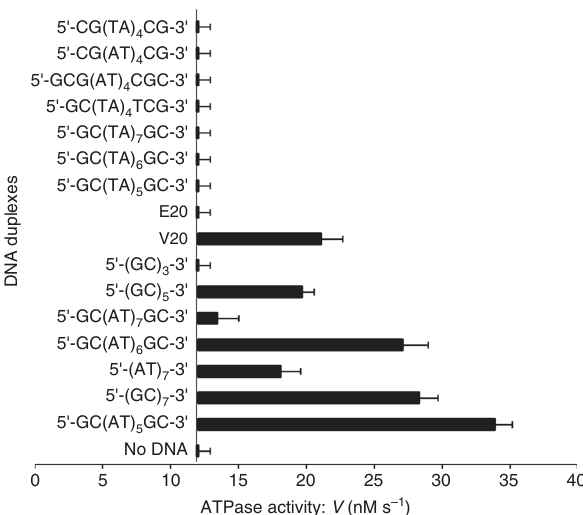
Fig. 7 Short DNA duplexes stimulate ATP hydrolysis by topoisomerase IV. Using the conditions described in the legend to Fig. 6, topo IV was incubated with 2 mM ATP in the absence and presence of a variety of short annealed oligonucleotide duplexes (10 µ g) and ATP hydrolysis was followed by a coupled assay. The results shown are the average of three independent measurements. In the absence of DNA, the basal ATPase activity of topo IV was 12.4 nM s − 1 . Asymmetric E20 and V20 are 20-mers of the E and V sites that bind as G (gate DNA) segments and are strongly cleaved by topo IV 22,30 and were produced in duplex form by annealing complementary strands as carried out for 5 ′ -GC(TA) 4 TCG-3